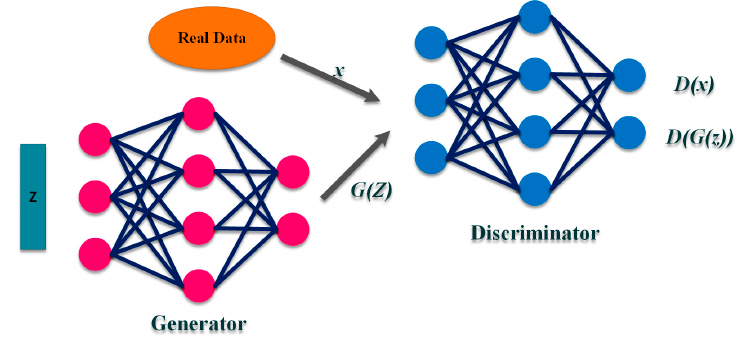
Figure 19. Structure of the SVM-based CVR quantification method [127].